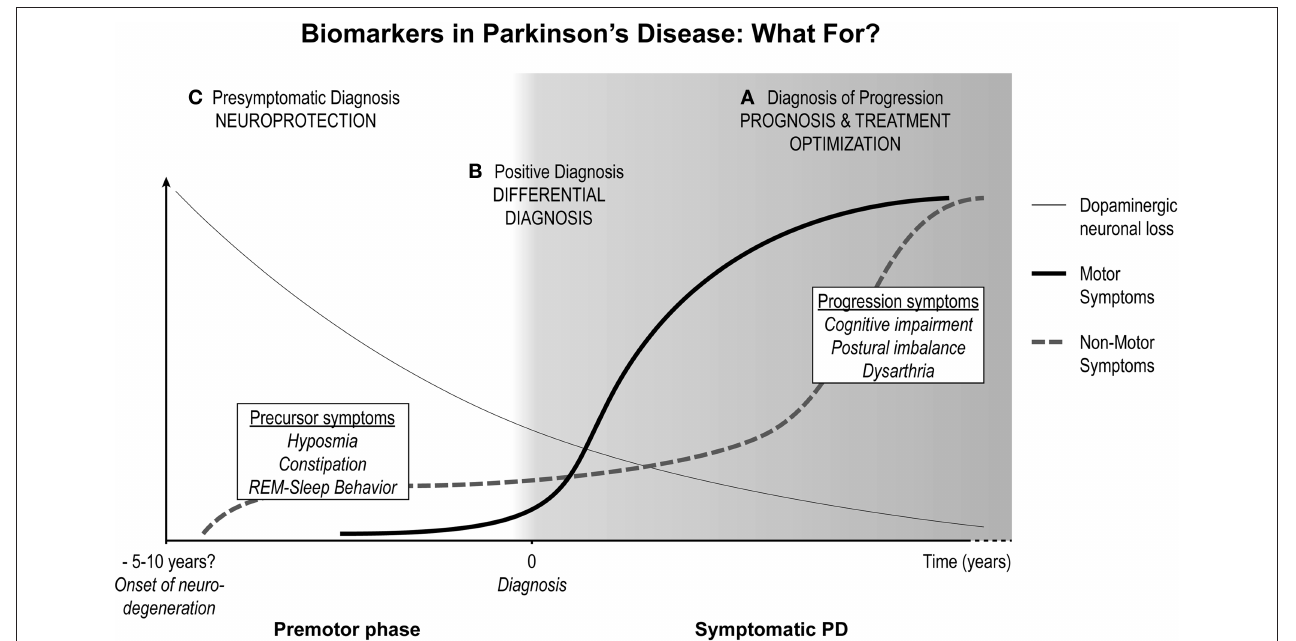
Figure 1 | The three purposes of biomarkers in Parkinson’s disease. Schematic representation of the clinical progression of Parkinson’s disease (PD). The thin line represents the continuous degeneration of the dopaminergic neurons of the substantia nigra . When dopaminergic neuronal loss reaches > 50%, cardinal motor symptoms appear ( thick line ) and PD becomes fully symptomatic ( gray background ). Motor symptoms worsen over time but respond to dopamine replenishment therapy. During the premotor phase ( white background ) non-motor symptoms ( dotted line ) may already be present. Non-motor symptoms burden also increases with time but contrary to motor